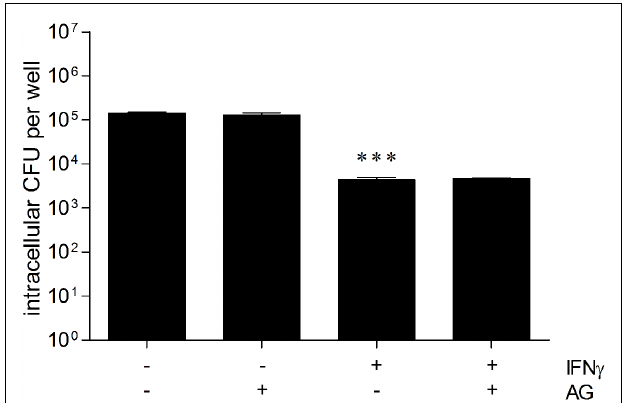
FIGURE 5 | Inducible nitric oxide synthase (iNOS) is not necessary to eliminate B. pseudomallei in hepatocytes . Intracellular replication of B. pseudomallei E8 24h after infection (MOI 40:1) of resting and IFN γ -activated (500ng/ml) HepG2 cells in the presence of iNOS inhibitor aminoguanidine (AG, 2mM). Data are presented as mean with SEM of triplicate determinations. One representative experiment out of three